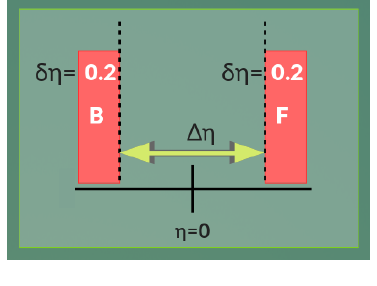
Figure 1: The illustration of the concept of measurement of forward-backward cor- relation for symmetrical (with respect to η = 0) forward-backward intervals in pseu- dorapidity of width δη = 0 . 2, and the sepa- ration gap ∆ η